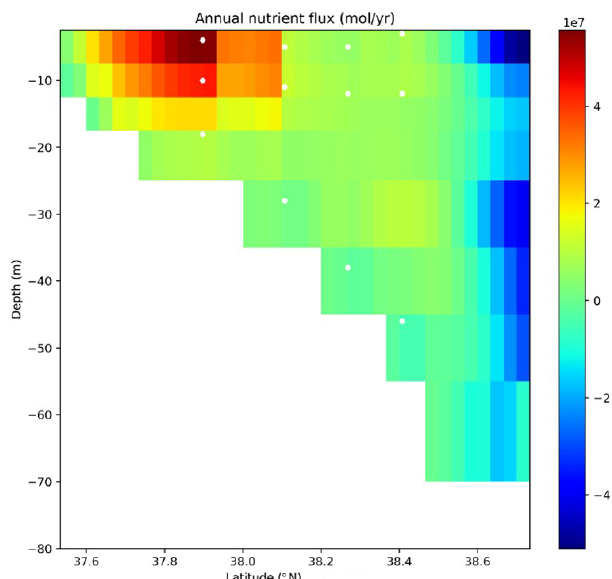
Figure 9. Simulated net fluxes of nitrate (molyr − 1 ) in the Bohai Strait for the year 2018. White dots are the sampling sites, the color bar is the flux of nitrate (10 7 molyr − 1 ), and positive values stand for the export of nitrate from BHS to